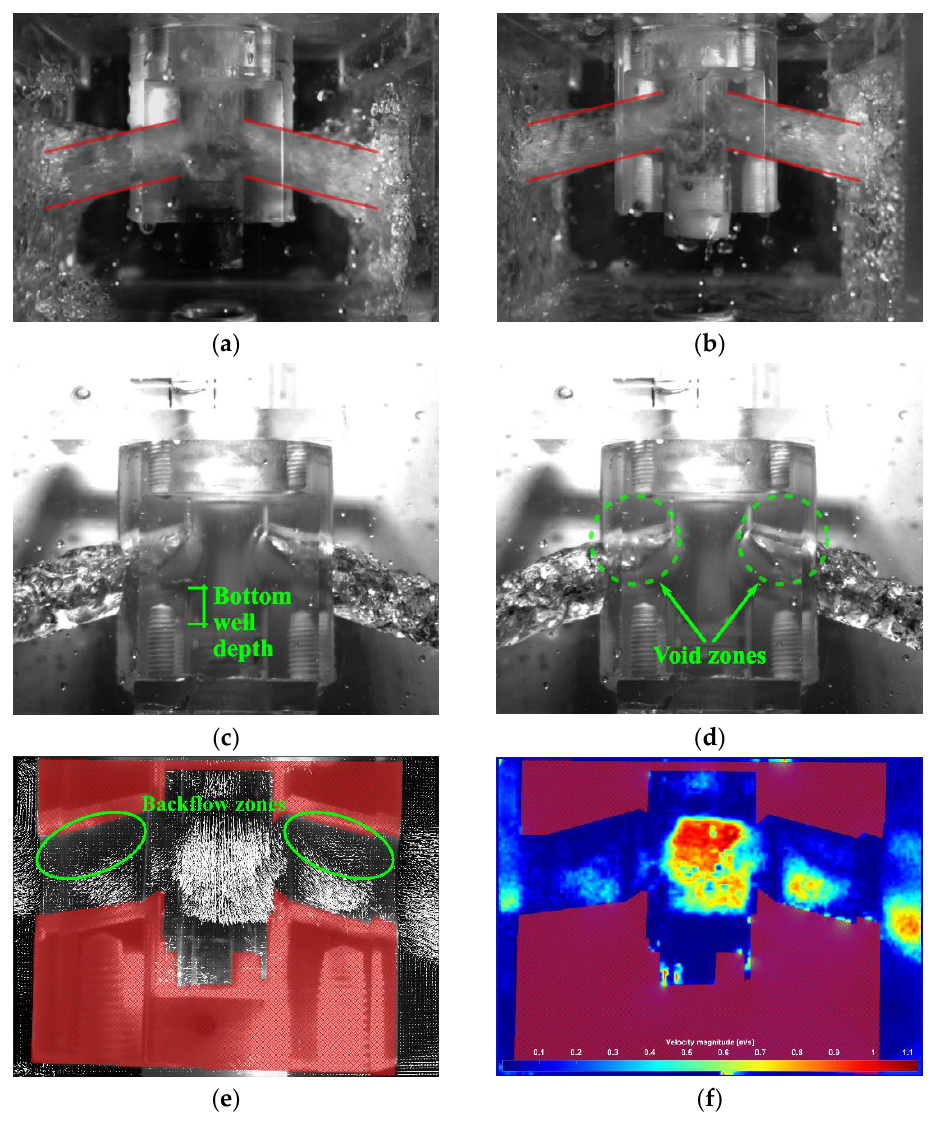
Figure 14 . Physical simulations results. ( a ) Outlet jets emerging from a WB-nozzle. ( b ) Outlet jets emerging from a WBFD-nozzle. ( c , d ) Two instants of the same WBFD-nozzle test. ( e ) Inner fluid flow pattern reconstructed through PIV analysis. ( f ) Velocities map reconstructed through PIV analysis.